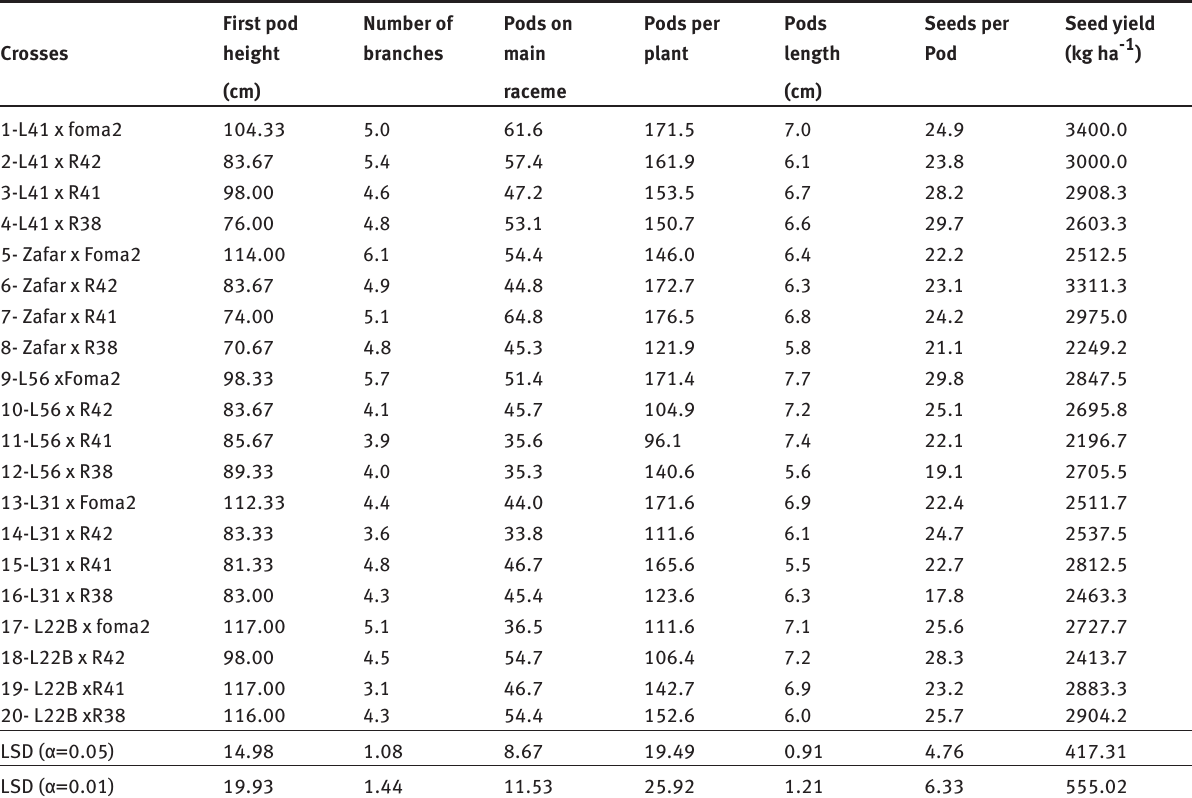
Table 5: Means of the crosses for yield components and seed yield First pod Number of Pods on Pods per Pods Seeds per Seed yield Crosses height branches main